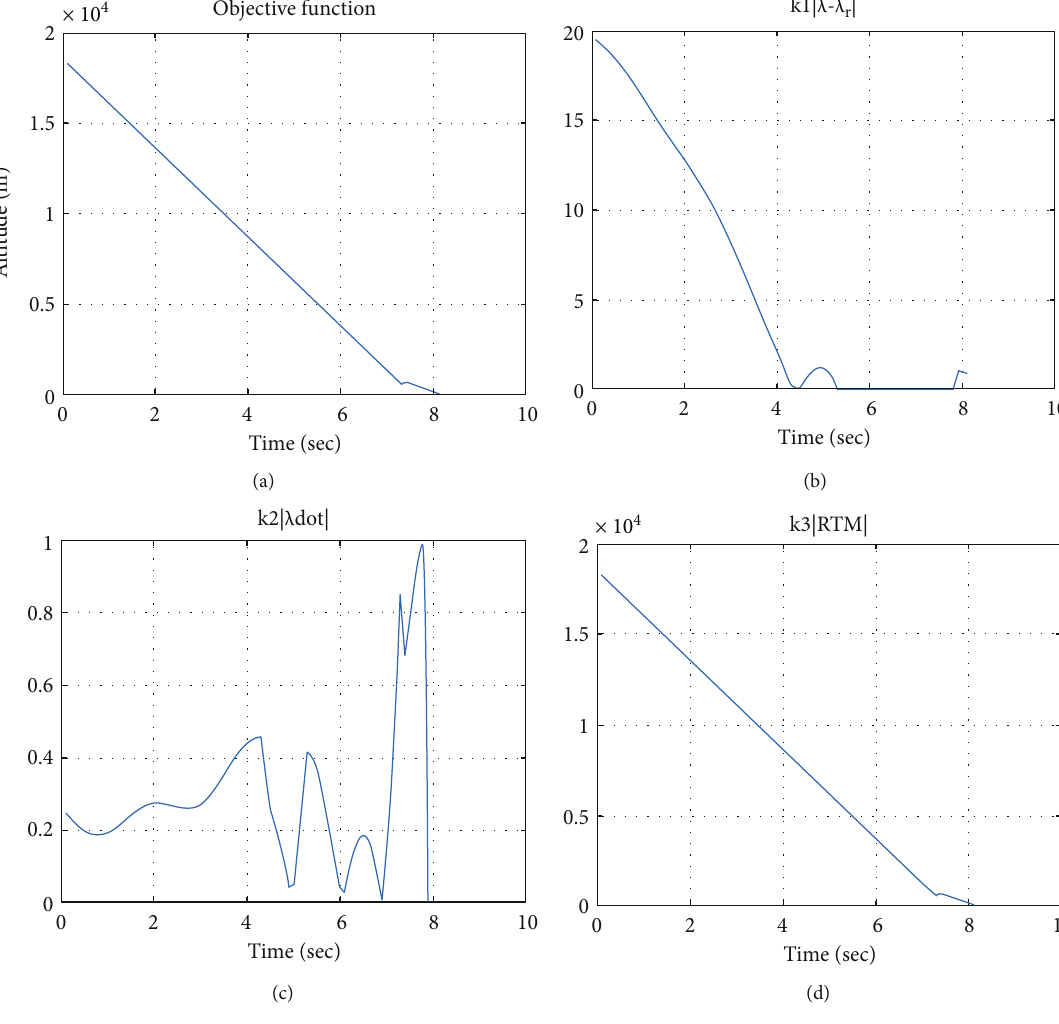
Figure 7: Performance index of intercepting weave-maneuvering hypersonic targets. Table 2: The initial condition for the missile and target. R M